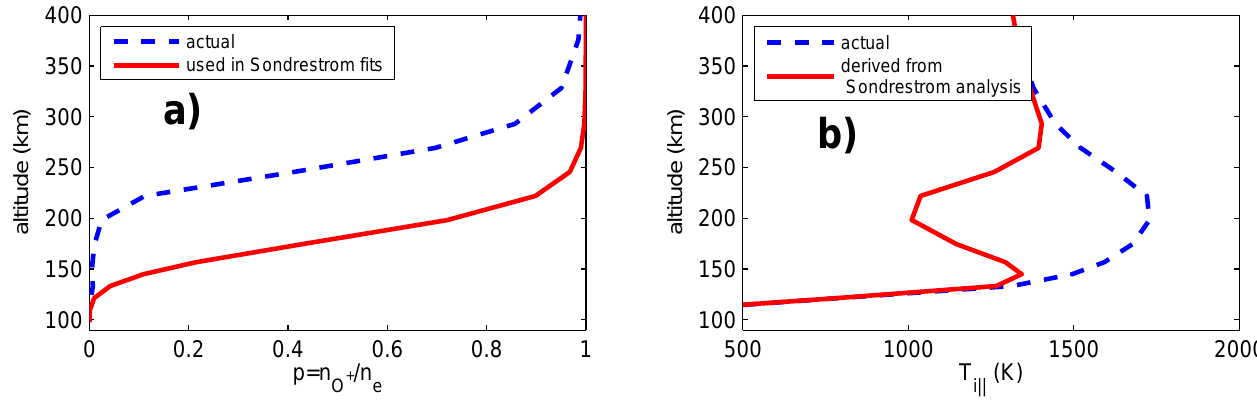
Fig. 5. Illustration of the effects of fitting IS spectra with an incorrect composition model. Panel (a) actual (modeled) composition for E ⊥ =50mVm − 1 and the composition used in fitting Sondrestrom data. Panel (b) modeled ion temperature for E ⊥ =50mVm − 1 and temper- ature derived using the red line composition profile from panel (a).